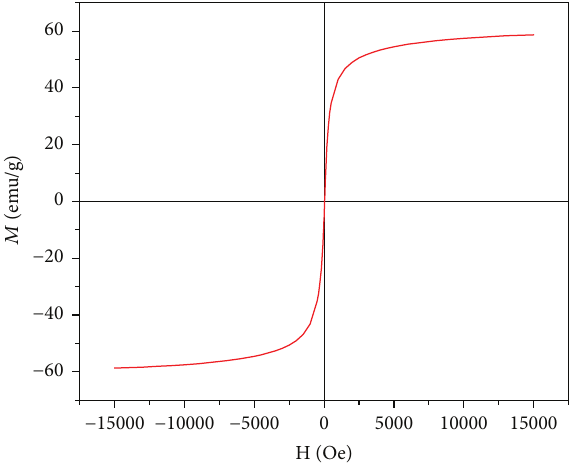
Figure 5: Magnetization curve of Fe 3 O 4 /rGO.